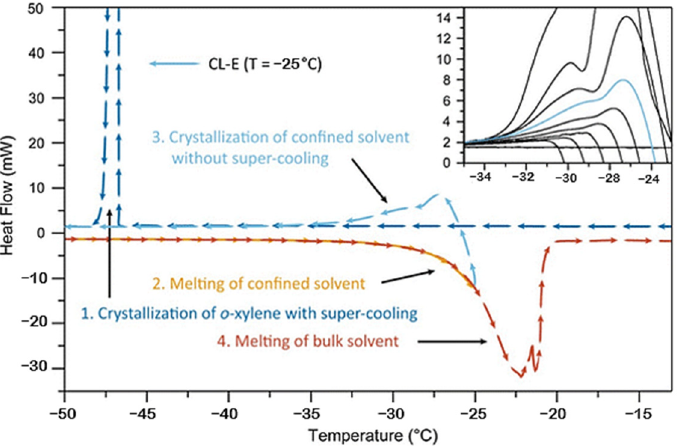
Figure 7. DSC thermogram of aerogels obtained for the determination of pore size by thermoporometry (reprinted from [86] with permission). Table 4. Average pore size (Ø) according to thermoporometry analysis and nitrogen sorption ex- periments at 77 K, TBAF/DMSO (CL-TBAF), [EMIm] [Oac]/DMSO (CL-EMIm), NMMO · H 2 O